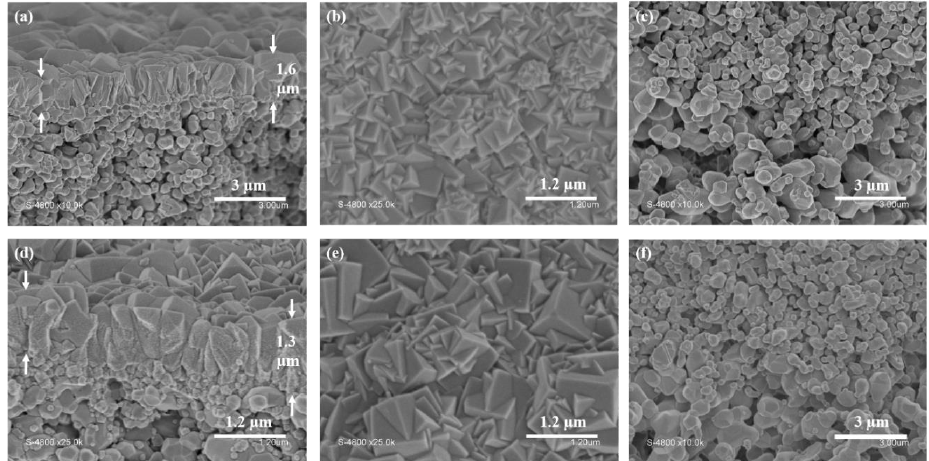
Figure 2. SEM images of ( a ) inner support layer cross-section, ( b ) inner support surface top view, ( c ) cross-section of inner and intermediate support layer with UiO-66 membrane; ( d ) cross-section of inner support layer, ( e ) top view of inner support surface, ( f ) cross-section of inner and intermediate support layer with UiO-66-NH 2 membrane.